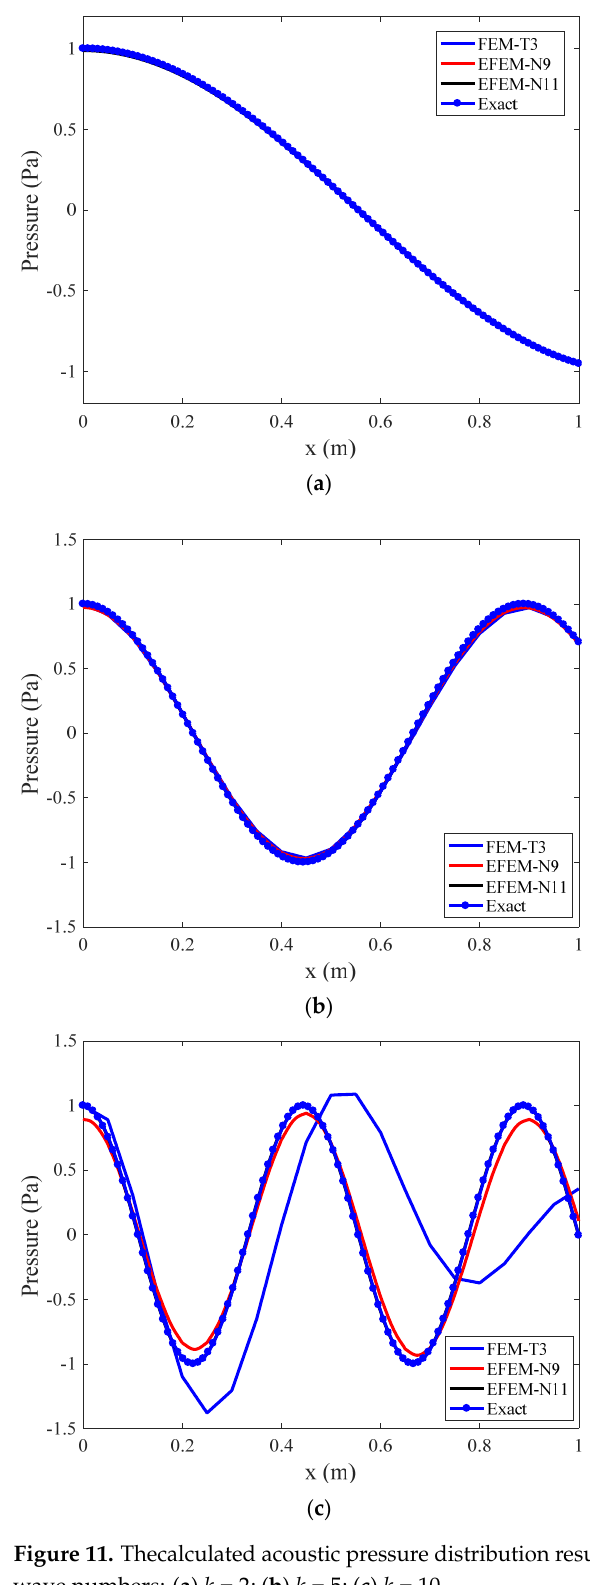
Figure 11. Thecalculated acoustic pressure distribution results along the de fi ned path for the vary- ing wave numbers: ( a ) k = 2; ( b ) k = 5; ( c ) k =